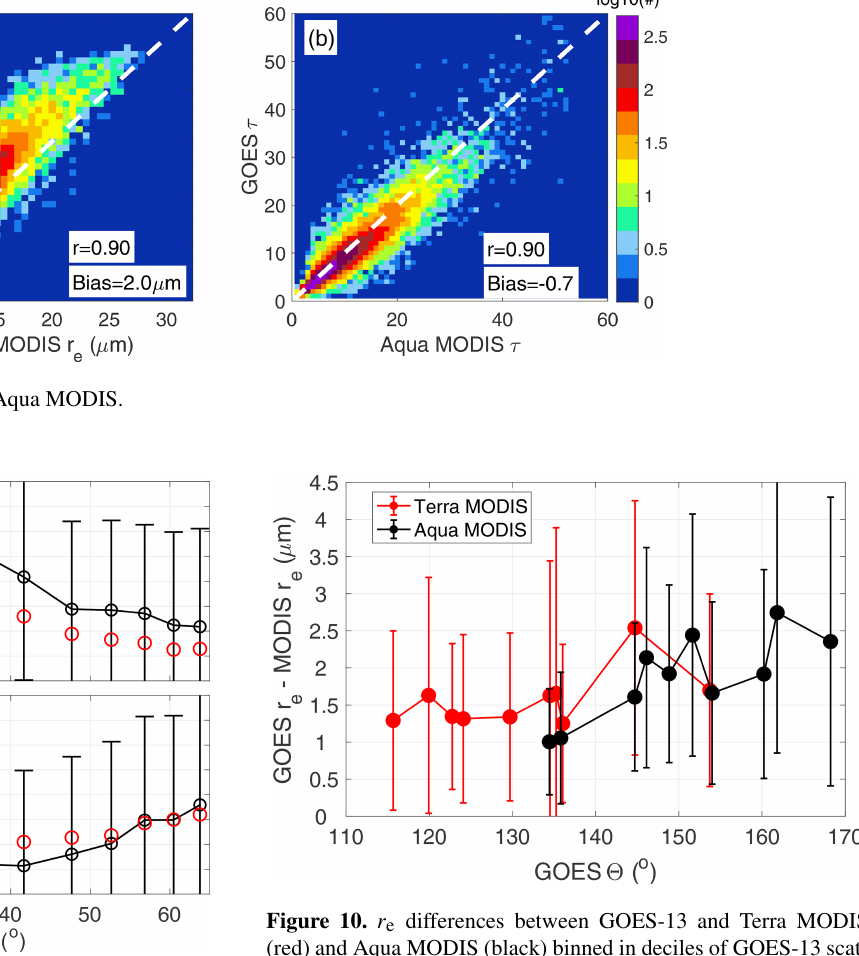
Figure 9. Mean differences between GOES and Aqua/Terra MODIS retrievals binned in MODIS VZA deciles: (a) cloud effec- tive radius and (b) cloud optical depth. Error bars denote the stan- dard deviation, and median values are represented by red circles.